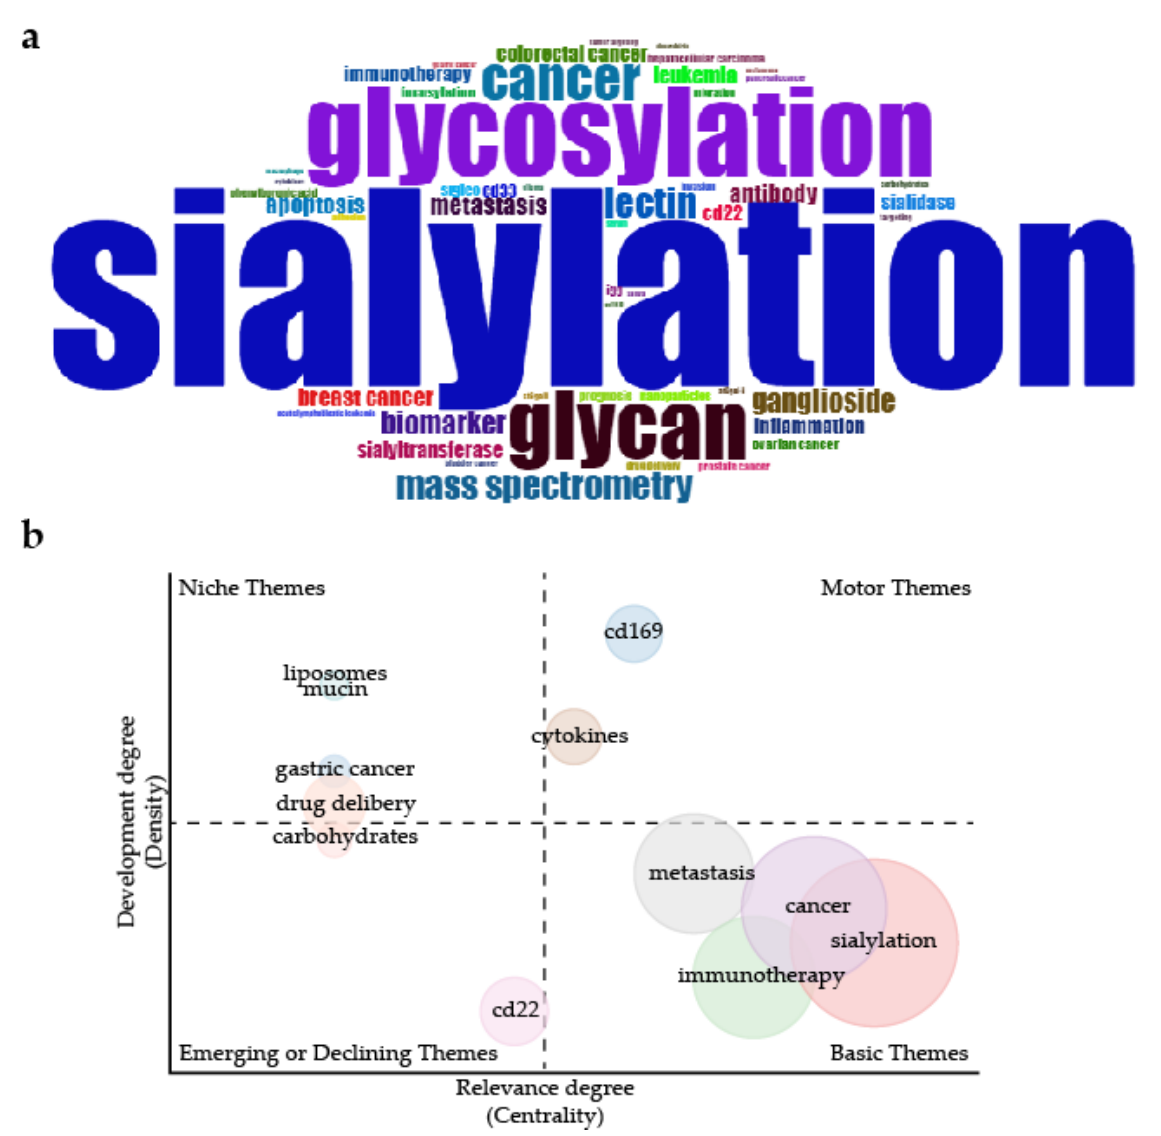
Figure 2. Keywords and topics analysis of articles about cancer sialylation: ( a ) WordCloud showed the top 50 most frequent words. The frequency of keywords determined the font type; and ( b ) thematic map plotted by the authors ’ keywords. Both ( a , b ) were plotted automatically using the bibliometrix package in R version 4.2.0 based on the authors ’ keywords in the retrieved articles.